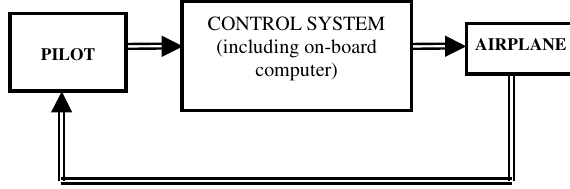
Fig 1. The schematic of manual-computer-aided